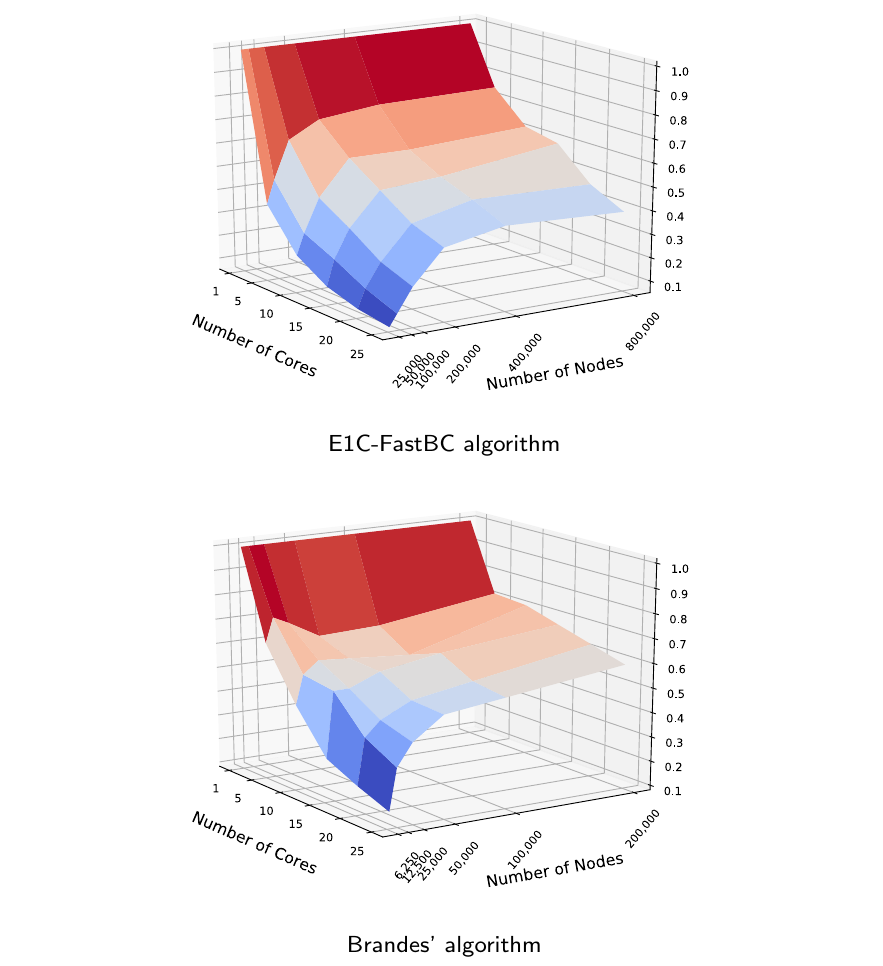
Fig. 8 Comparison with Brandes’ algorithm. Efficiency analysis- E p =[ 1,5,10,15,20,25